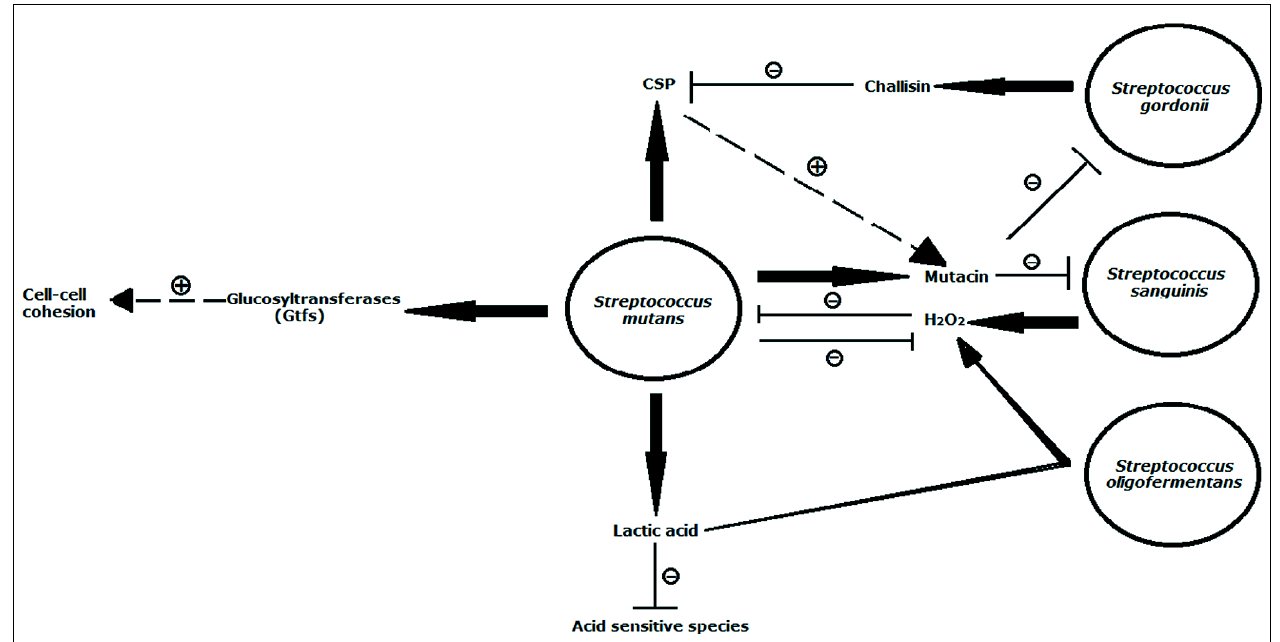
FIGURE 1 | Illustration of interspecies interactions between Streptococcus mutans and selected oral streptococci that have been studied on a molecular level. Depicted is the production of lactic acid, mutacin, glucosyltransferases (Gtfs), and CSP, which also enhances mutacin production by S. mutans . Lactic acid has been found to inhibit proliferation of a variety of acid-sensitive anaerobe species, but it was recently discovered to serve as a substrate for S. oligofermentans for H 2 O 2 production. This compound is also generated by S. sanguinis and was previously shown to inhibit growth of S. mutans. In order to counteract this antagonistic molecules, S. mutans produces some oxidative stress factors such as Dps-like protein (Dpr)